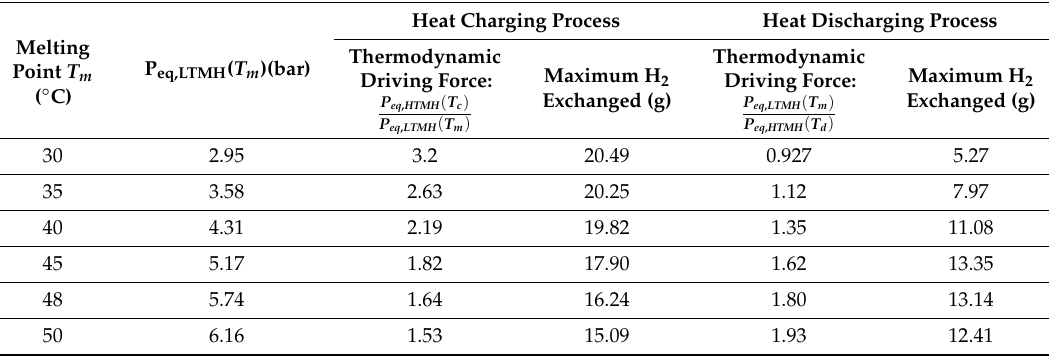
Table 3. The maximum H 2 exchanged between beds and thermodynamic driving force of the reaction calculated as the ratio of equilibrium pressure of metal hydride beds, during the heat